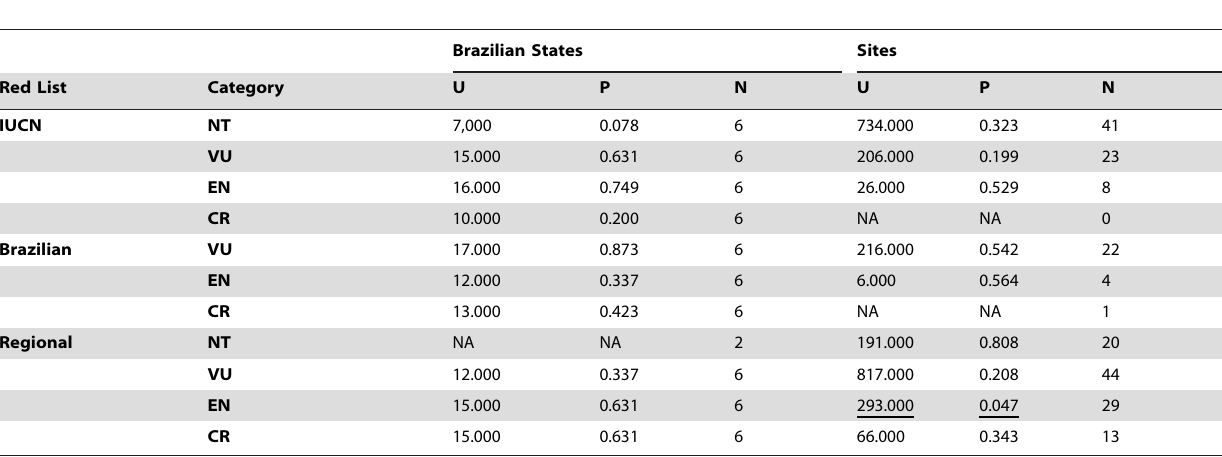
Table 4. Results for the Mann-Whitney tests comparing values of observed phylogenetic diversity and mean of randomized phylogenetic diversity of the analyzed Brazilian States and sites with threatened birds in categories of the IUCN, Brazilian and respective States Red Lists (see Supplementary Material for more